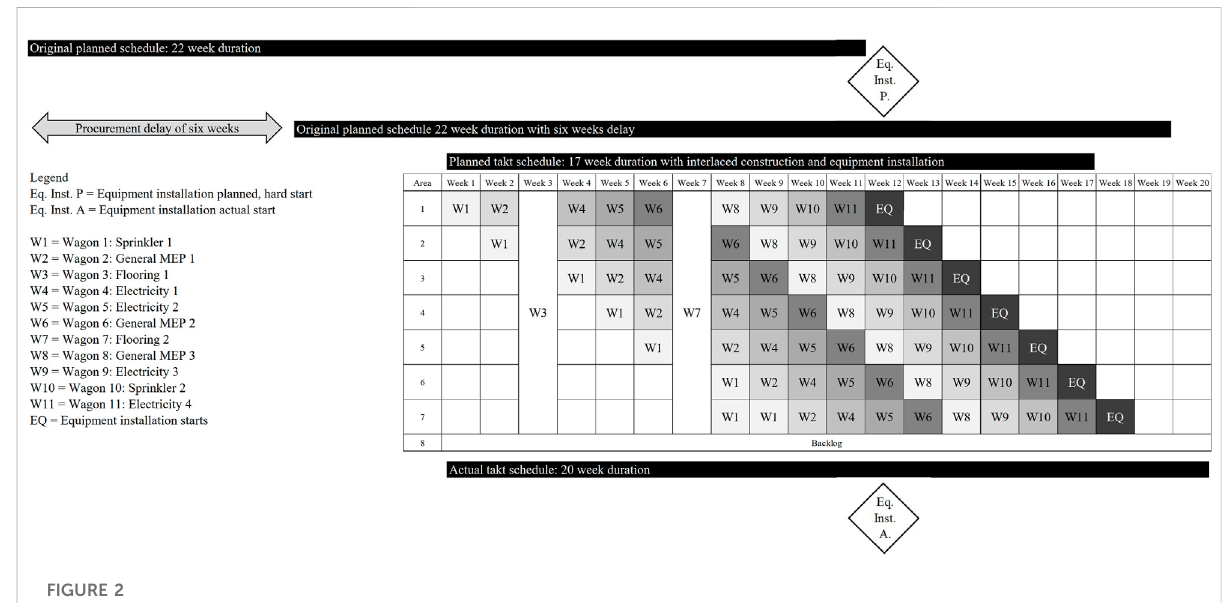
FIGURE 2 Implementation impact on project schedule